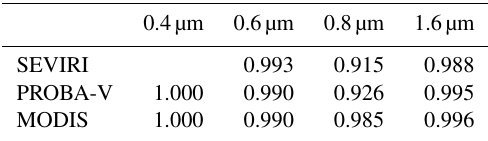
Table 4. Water vapour transmittance in the SEVIRI, PROBA-V and MODIS